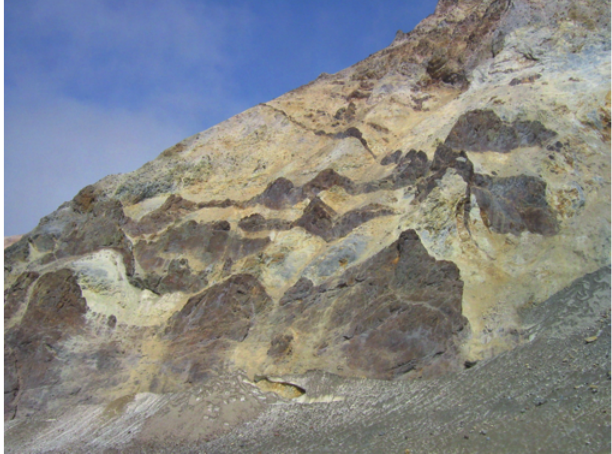
Figure 3. Dike swarm exposed in the wall of Mutnovsky III crater. Height of field of view is approximately 500 m (photo by J. Eichelberger).